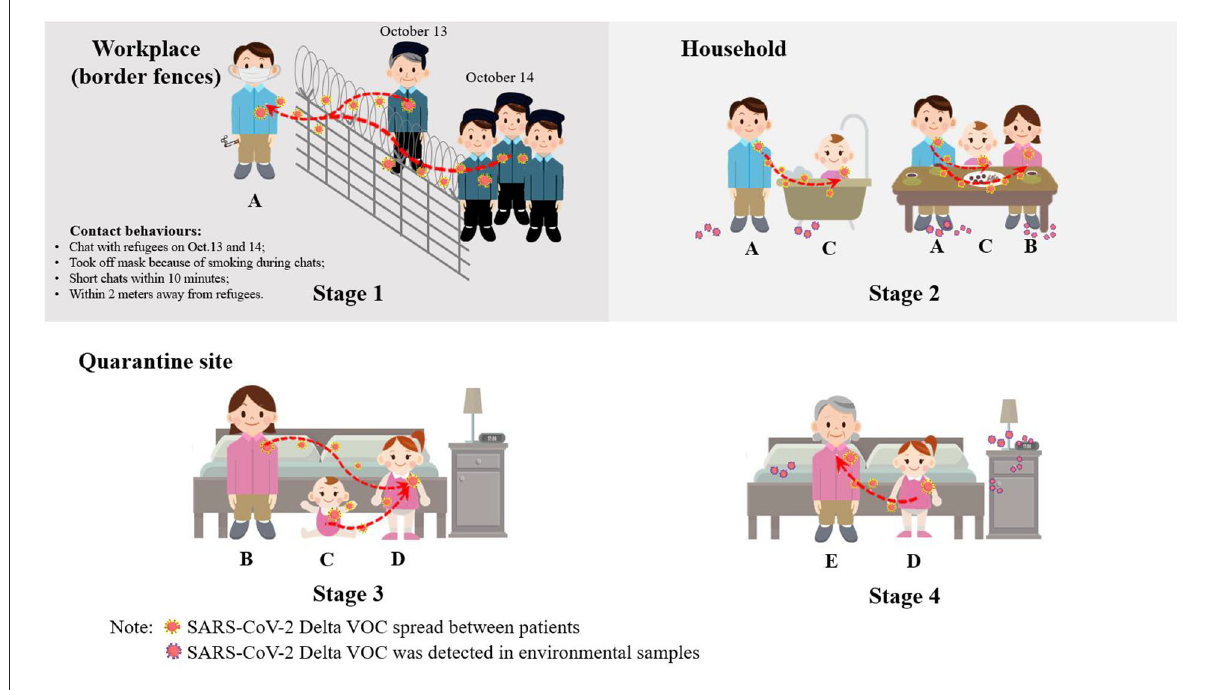
FIGURE2 Virus transmission